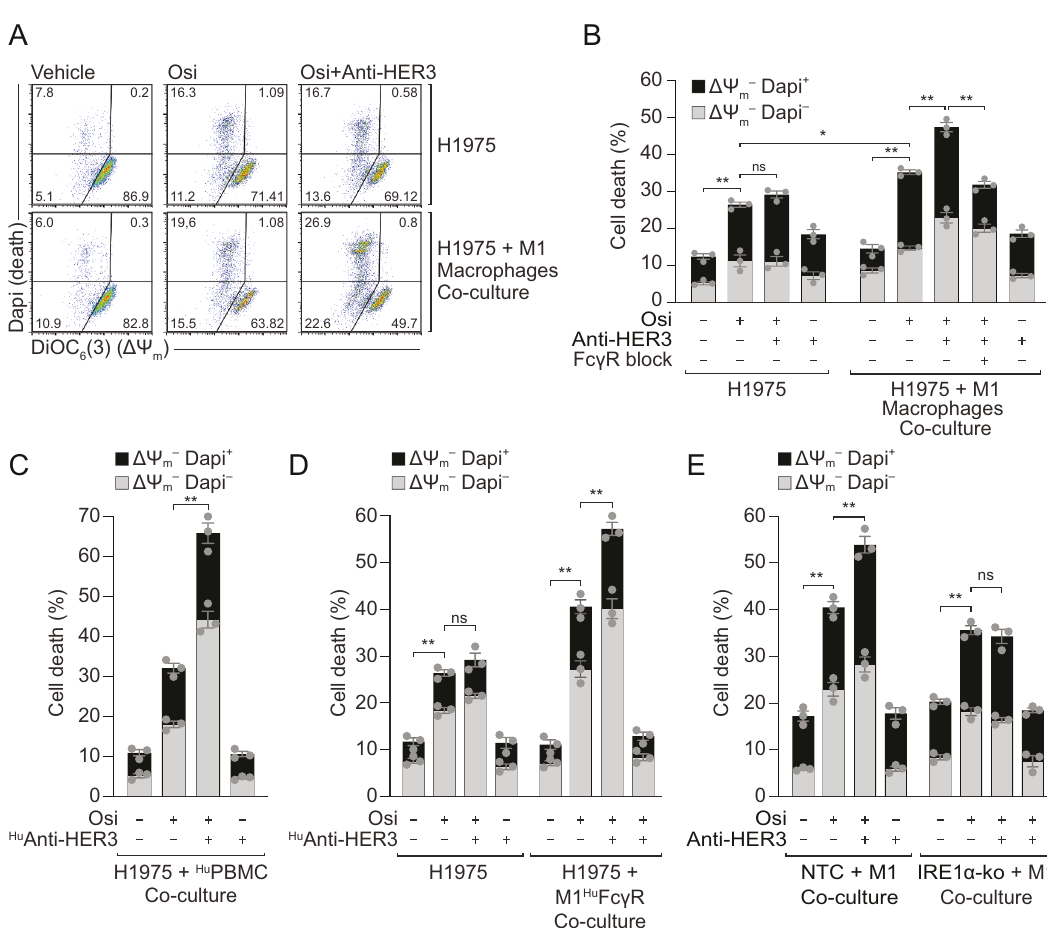
Fig. 3 Combination therapy with osimertinib and anti-HER3 antibodies triggers macrophage-mediated Fc γ R-dependent cell toxicity. A H1975 cells pre-treated with osimertinib (Osi, 200 nM, 24 h) were treated with anti-HER3 (MP-RM-1, 10 μ g/ml, 1 h) and then co-cultured with macrophages (2 h, ratio 10:1) pre-labelled with cell tracker. Apoptosis of H1975 cells was assessed by fl ow cytometry excluding bone marrow- derived macrophages (BMDM) as described in materials and methods. Dot plots are representative of 3 independent replicates. B Quanti fi cation summary from the representative data shown in panel A . H1975 cells alone or co-cultured with macrophages were assessed for apoptosis using fl ow cytometry with DiOC 6 (3) for mitochondrial transmembrane potential ( ΔΨ m ) and Dapi for cell viability, as described in materials and methods. Fc γ R block was added in co-culture conditions as indicated to assess Fc γ R function. Results shown as mean ± SEM from three replicates; * P < 0.05, ** P < 0.01 as indicated, using one-way ANOVA with Tukey ’ s test. C H1975 cells pre-treated with osimertinib (200 nM, 24 h) were treated with human anti-HER3 ( Hu Anti-HER3, EV20; 10 μ g/ml, 1 h) and then co-cultured with healthy-donor derived human PBMCs (2 h, ratio 10:1). Apoptosis of H1975 cells was assessed by fl ow cytometry excluding immune cells as described in materials and methods. Data are shown as mean ± SEM. ** P < 0.01 as indicated, using unpaired t -test with total values. D H1975 cells pre-treated with osimertinib (200 nM, 24 h) were treated with human anti-HER3 ( Hu Anti-HER3, EV20; 10 μ g/ml, 1 h) and then co-cultured with BMDM from chimeric humanised Fc γ R ( Hu Fc γ R) mice (2 h, ratio 10:1) pre-labelled with cell tracker. Apoptosis of H1975 cells was assessed by fl ow cytometry excluding macrophages as described in materials and methods. Gray and black bars as in Panel B . Data are shown as mean ± SEM. ** P < 0.01 as indicated, using unpaired t - test with total values. E Cas9/CRISPR stable NTC or IRE1 α -ko H1975 cells pre-treated with osimertinib (200 nM, 24 h) were treated with murine anti-HER3 (MP-RM-1, 10 μ g/ml, 1 h) and then co-cultured with M1-like BMDM from CD1-nude mice (M1; 2 h, ratio 10:1) pre-labelled with cell tracker. Apoptosis of H1975 cells was assessed by fl ow cytometry excluding macrophages as described in materials and methods. Gray and black bars as in Panel B . Data are shown as mean ± SEM. ** P < 0.01 as indicated, using unpaired t -test with total